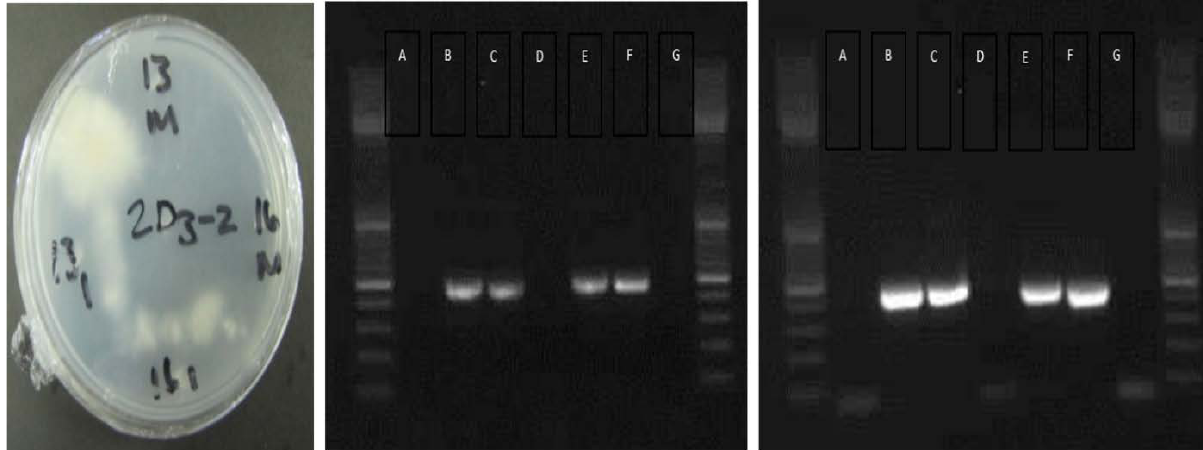
Figure 2: Identification of isolates collected from a commercial banana plantation in northern Mozambique as Fusarium oxysporum f. sp. cubense (Foc) TR4. (a) Heterokaryon (barrier) formation between nit -1 mutants of a Foc isolate collected at Metocheria farms and nit -M mutants of Foc TR4 (VCG 01213/16). (b) PCR amplification using Foc TR4-specific primer set developed by Dita et al. 21 (c) PCR amplification using a Foc